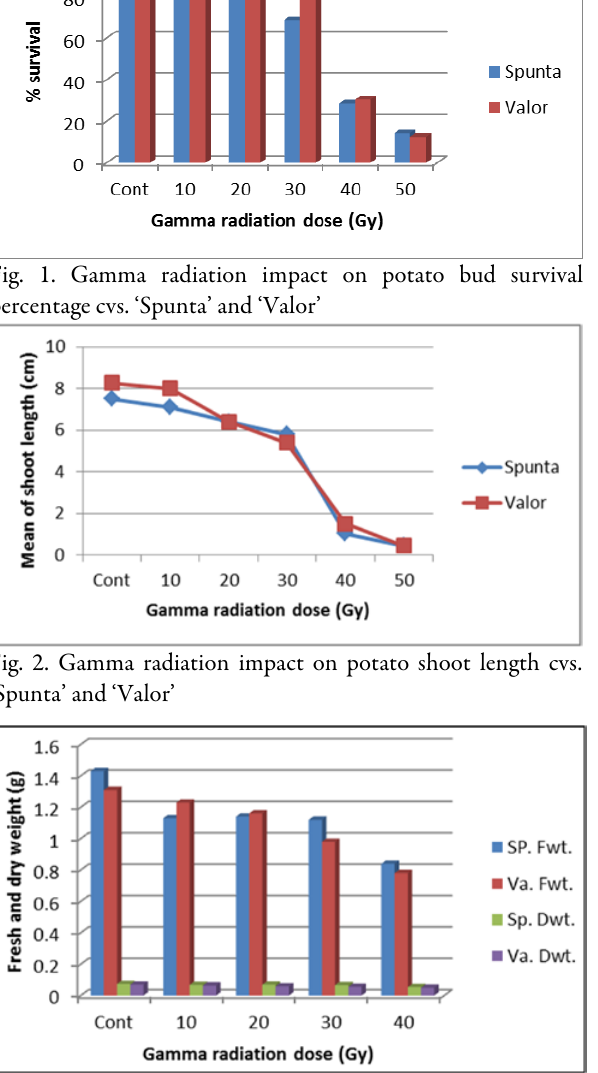
Fig. 3. Gamma radiation impact on potato plantlets fresh and dry weight cvs. ‘Spunta’ and ‘Valor’